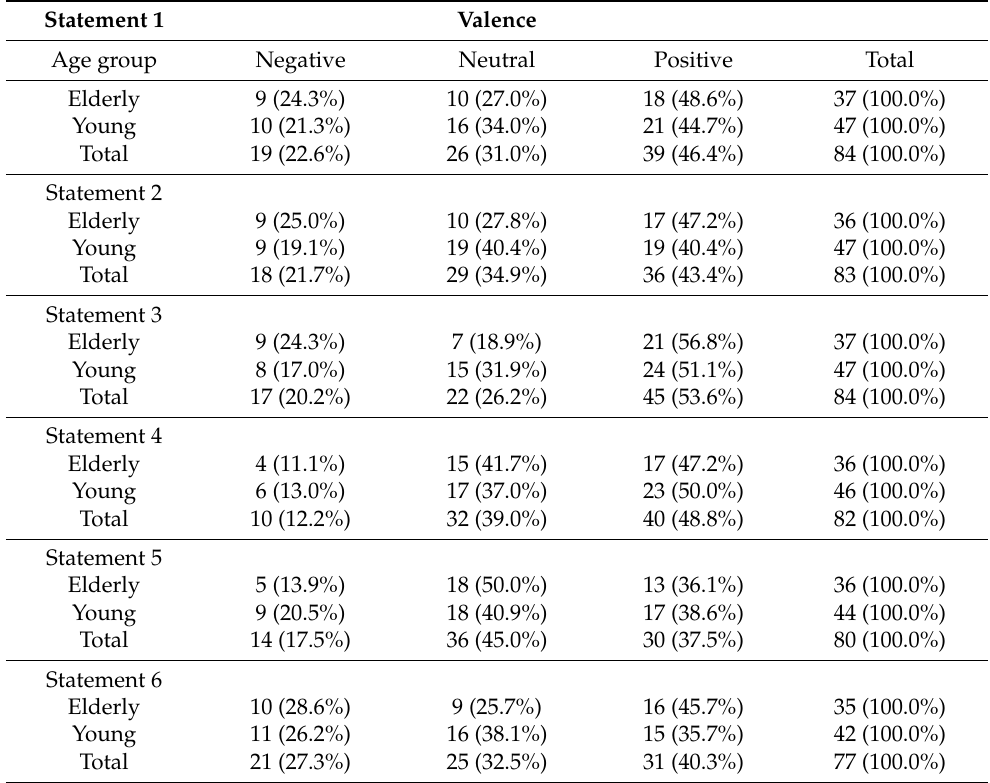
Table 2. Crosstabulation of age group by emotional valence for each statement of the